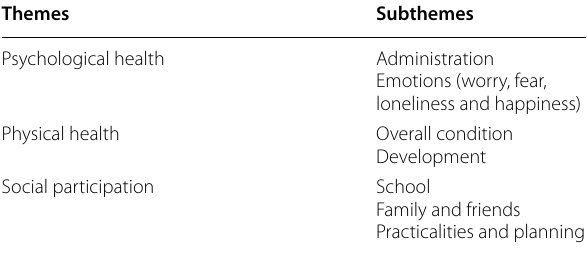
verbatim quotes from participants Table 3 Themes and subthemes retrieved from interview data